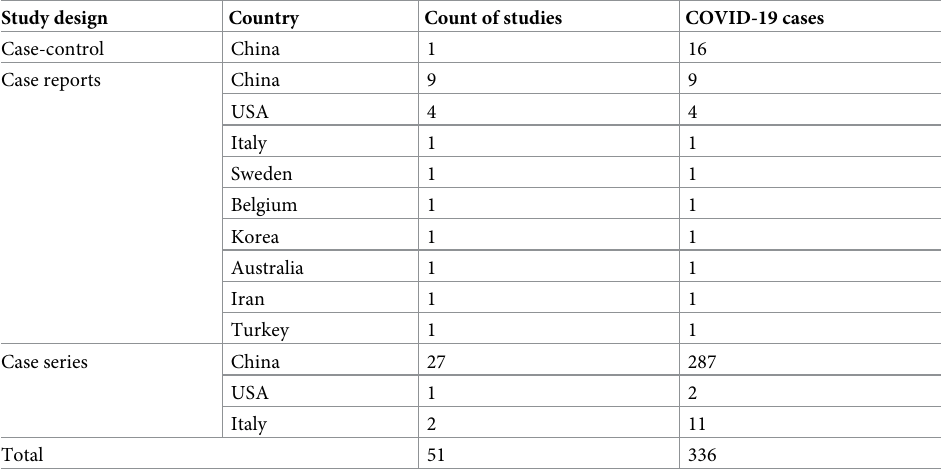
Table 1. Types of studies included in the